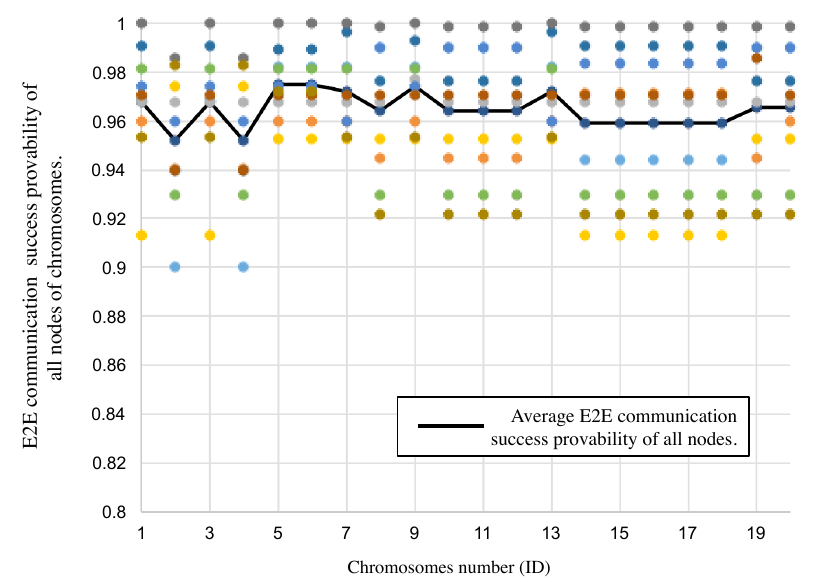
Figure 13. E2E communication “3”y of all nodes in the top 20 individuals and average one of all nodes in each individual.